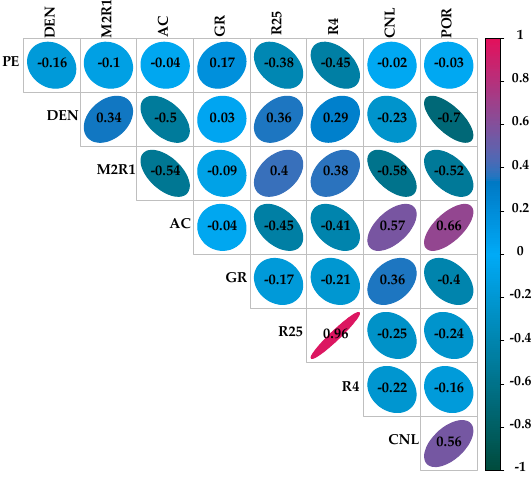
Figure 4. Correlation between parameters based on Pearson algorithm.